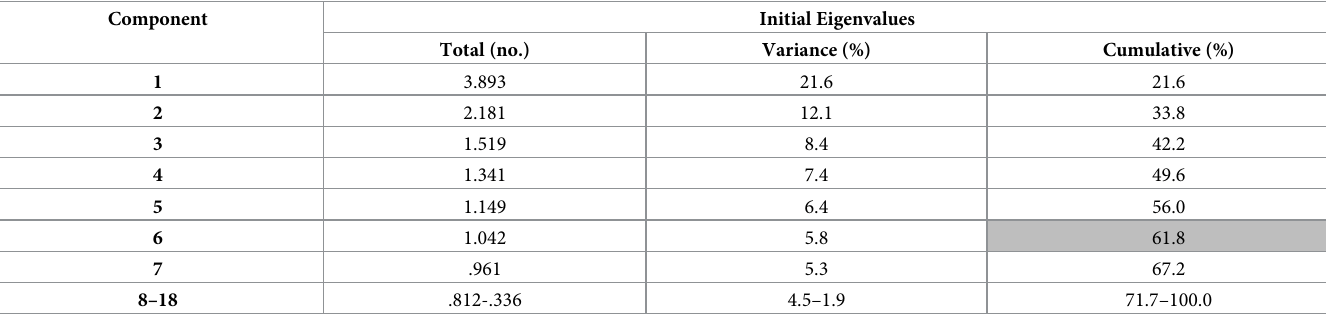
Table 3. Variance and cumulative values of major components.